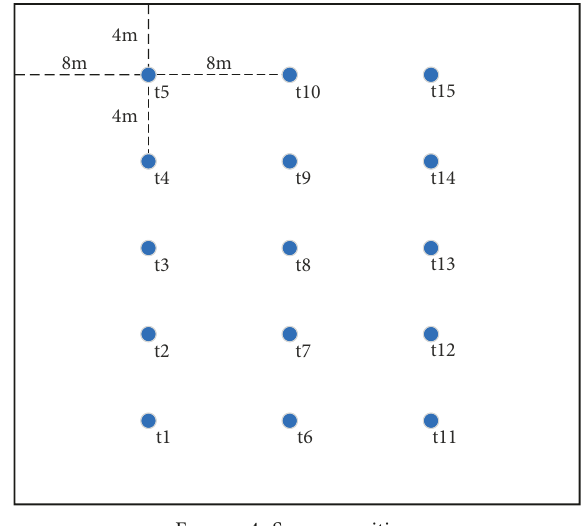
Figure 4: Sensor position.